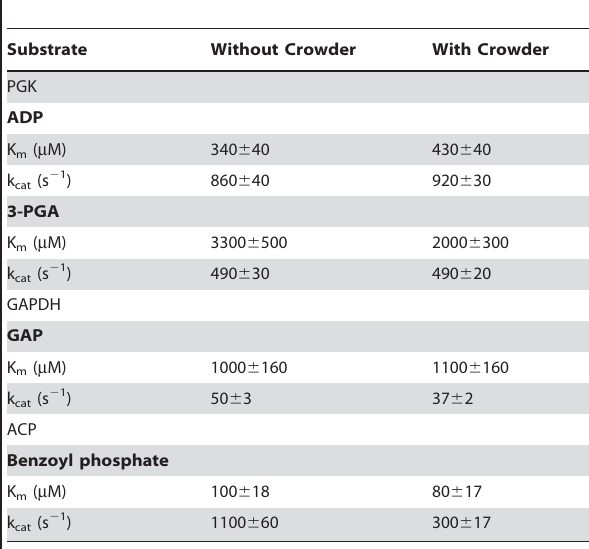
Table 1. Kinetic parameters of PGK, GAPDH and ACP in the absence or presence of the crowding agent